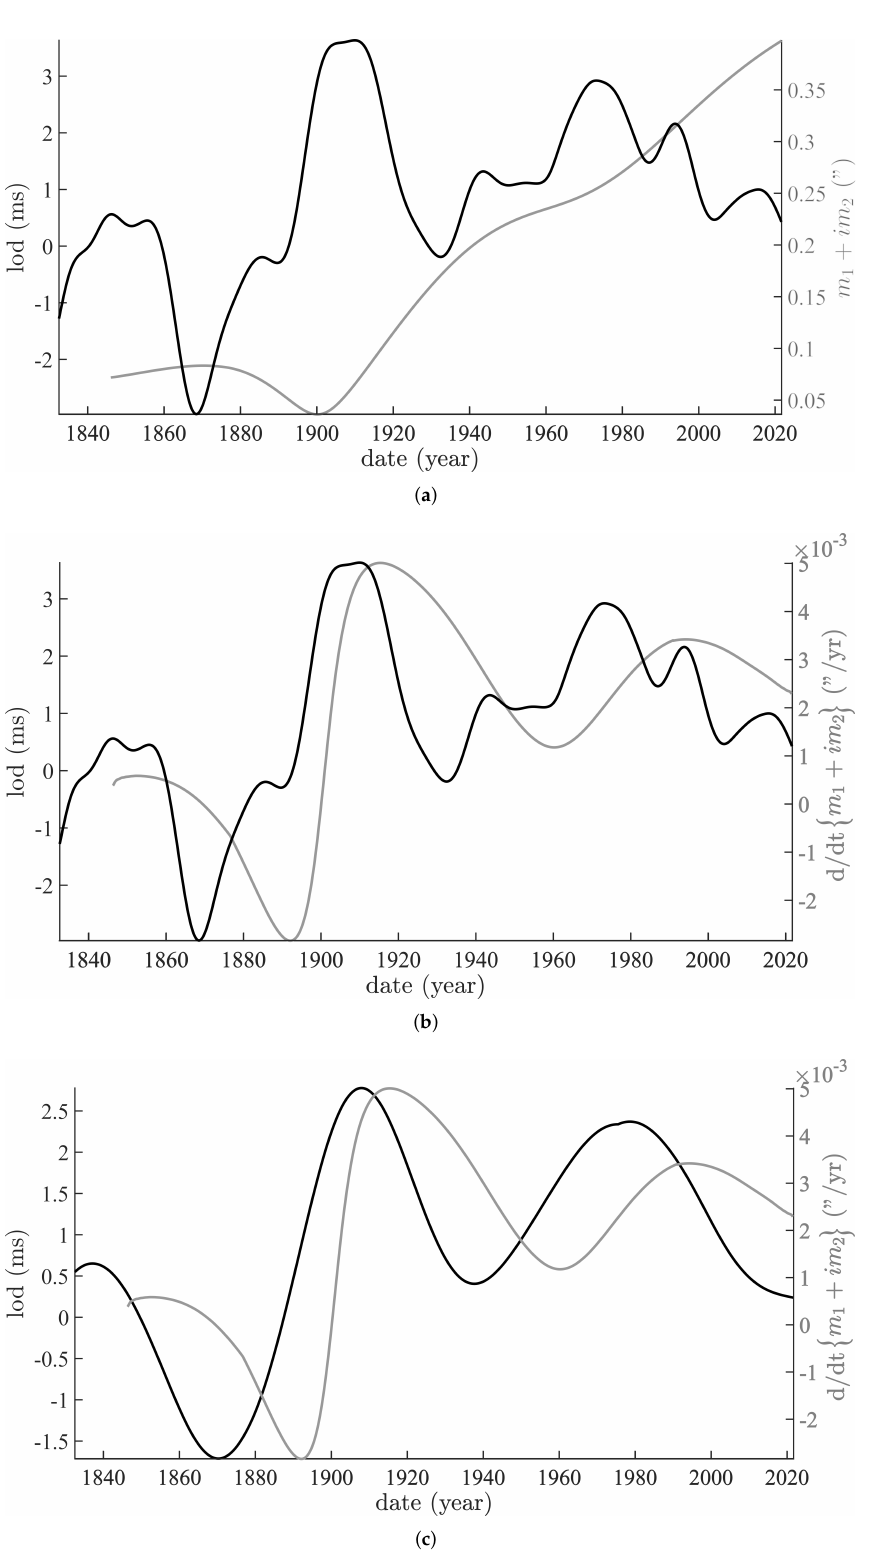
Figure 4. Polar motion from IERS ( a ) Comparison of the trends of the Morisson/ IERS lod (black) and of polar motion m (gray). ( b ) Comparison of the trend of the Morisson/ IERS lod (black) and of the derivative of the Markowitz drift (gray). ( c ) Comparison of the smoothed trend of the Morisson/ IERS lod (black) and of the derivative of the Markowitz drift